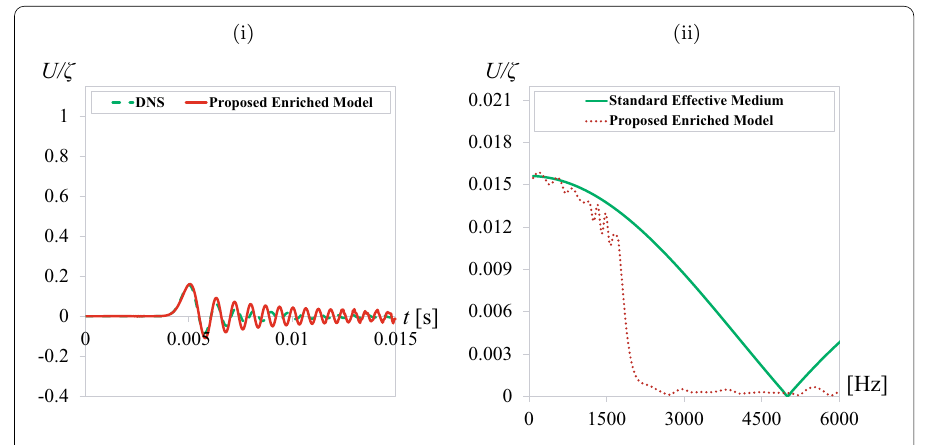
Fig. 8 Metamaterial 2— i Homogenized displacement profile at x = 20 D for loading frequency F at 10,000 Hz, with respect to relaxation time [A] ( κ = ∞ ), and ii the respective frequency plot arising from Discrete Fourier